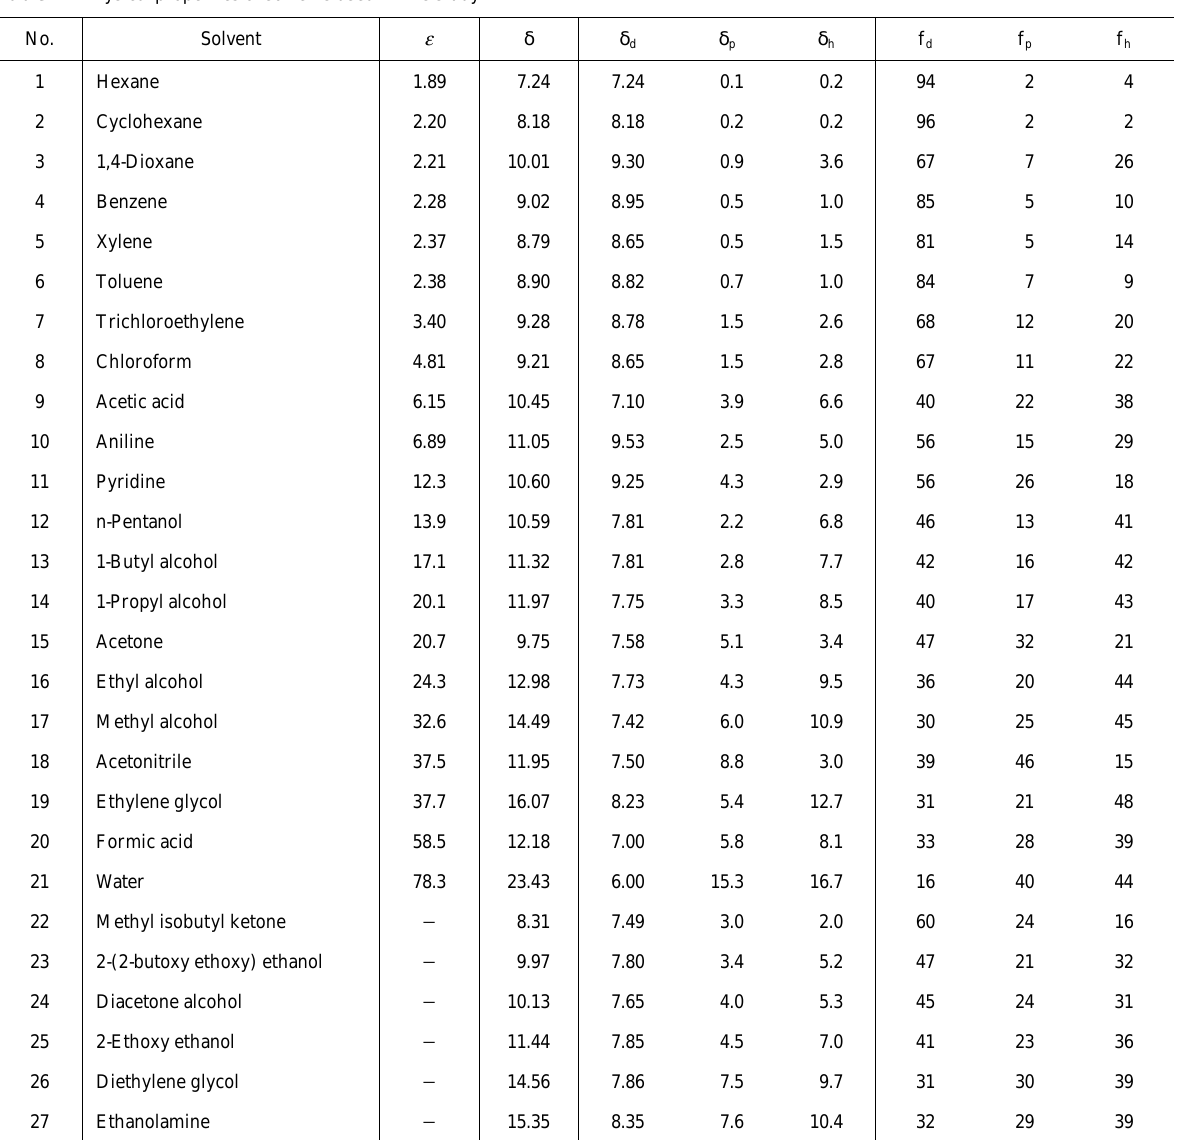
Table 1 Physical properties of solvents used in this